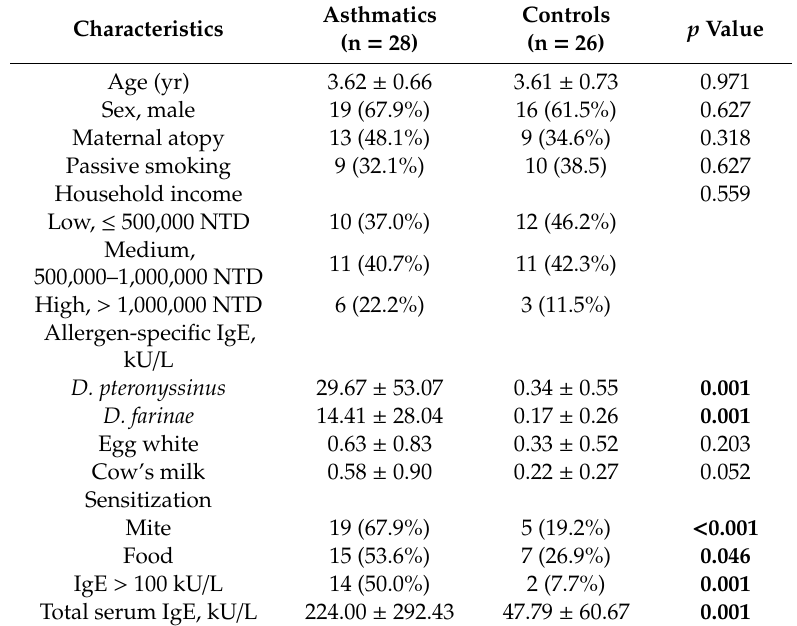
Table 1. Epidemiologic characteristics of the 54 children investigated in this study.